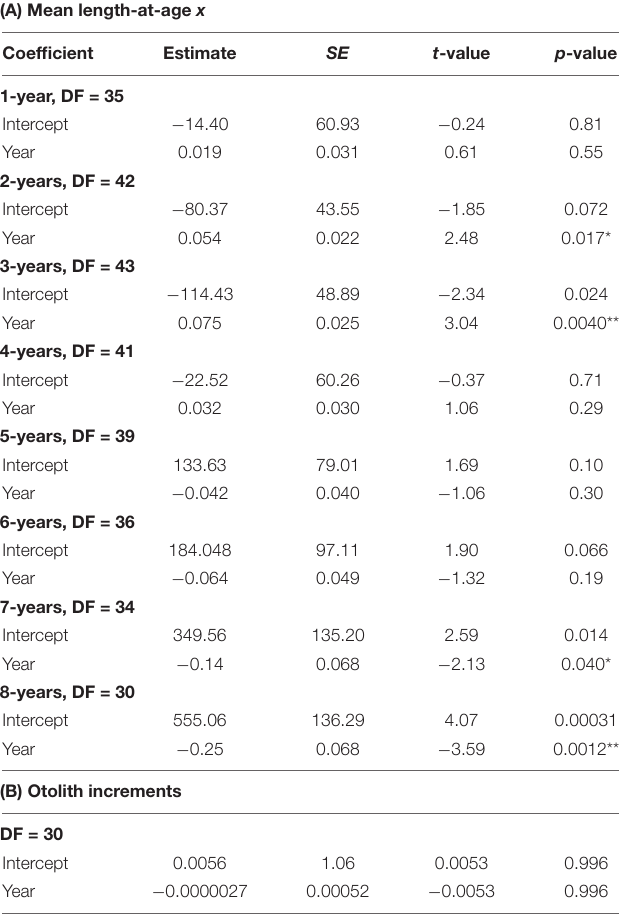
TABLE 4 | Regression results of (A) Mean length-at-age 1–8 years against year of sampling (Year), calculated from otolith-based age-length keys of Merluccius paradoxus caught off Namibia 1977 to 1987 from literature (ICSEAF, 1977, 1978, 1979, 1980, 1981, 1982, 1983b, 1984, 1985, 1987) and 1999 to 2016 from current data (SP, MFMR, and Supplementary Table S1 ) and (B) BLUP of growth from the otolith increments against